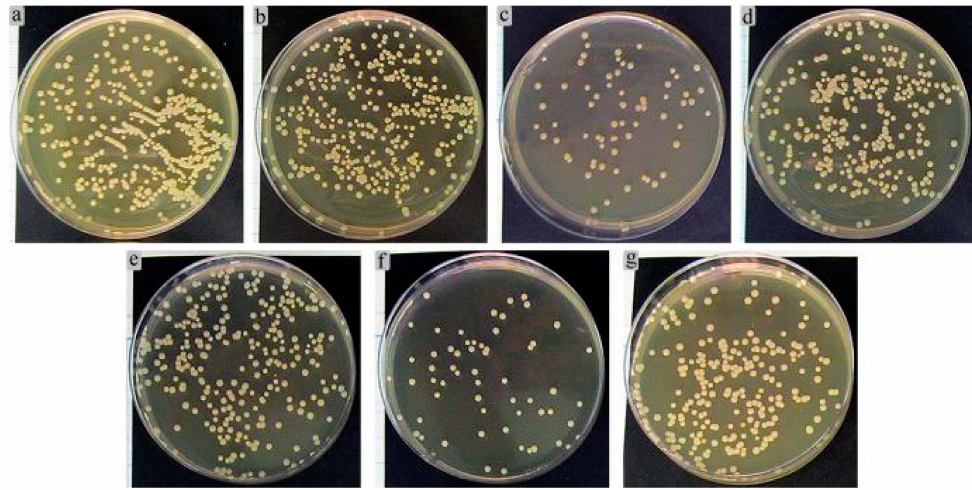
Figure 15. Results of 24-h growth of S. aureus in agar medium after preliminary 2-h co-cultivation with extracts of ( a ) Ti–6Al–4V; ( b , e ) CaP coatings; ( c , f ) Zn-CaP coatings; ( d ) Ti–6Al–7Nb; ( a – c ) Ti–6Al–4V substrate; ( d – f ) Ti–6Al–7Nb substrate; ( g ) 0.9% NaCl (control). Table 6. Results of 24-h growth of viable S. aureus 209P in agar medium after preliminary